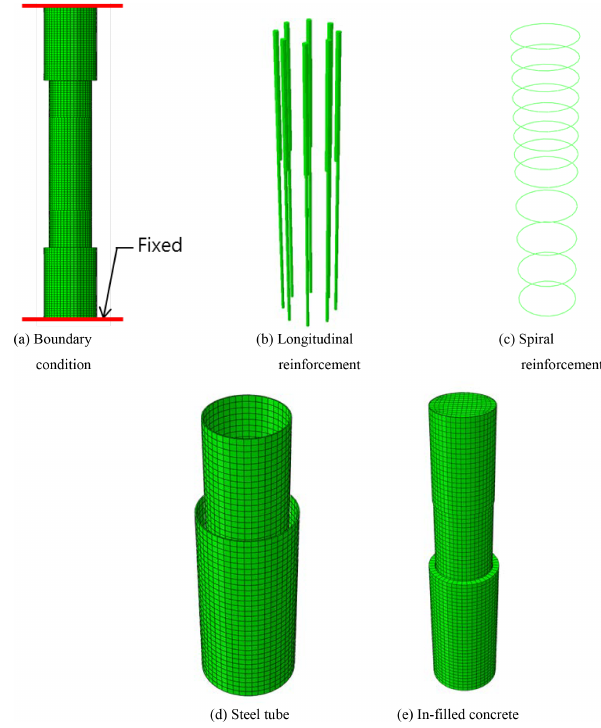
Figure 15. Details of 3-D model for test